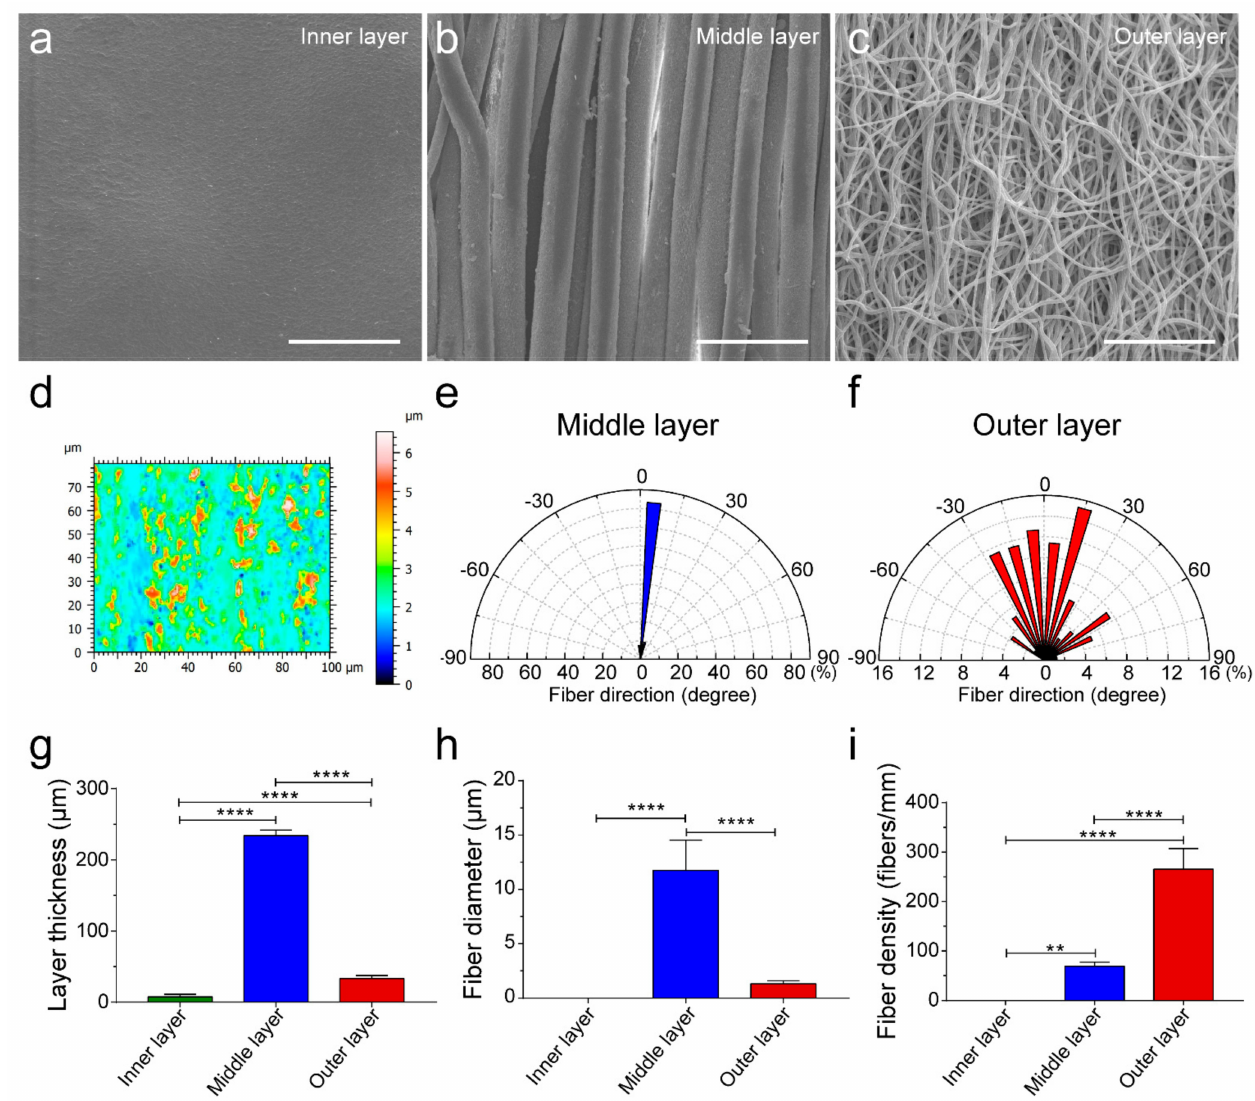
Figure 2. Characterization of the smooth inner layer, circumferentially aligned fibrous middle layer, and randomly distributed fibrous outer layer of TVGs. ( a – c ) SEM images showing the topological structure of the inner layer ( a ), middle layer ( b ), and outer layer ( c ) of TVGs. ( d ) White light interferometer images representing the low roughness of the smooth inner layer. The color scale indicates the relative height of the smooth film surface. The smaller the color difference shown in the image, the smoother the film surface is. ( e , f ) The wind rose diagrams indicate the highly organized and aligned fibers within the circumferentially aligned fibrous middle layer, whereas the arbitrary orientation of individual fibers was observed in the randomly distributed fibrous outer layer. ( g – i ) Quantitative analysis of the layer thickness ( n = 3), fiber diameter ( n = 100), and fiber density ( n = 6) of TVGs using SEM images. The results are expressed as the mean ± s.d., ** p < 0.01 and **** p < 0.0001. Scale bars: ( a – c ) 50 µ